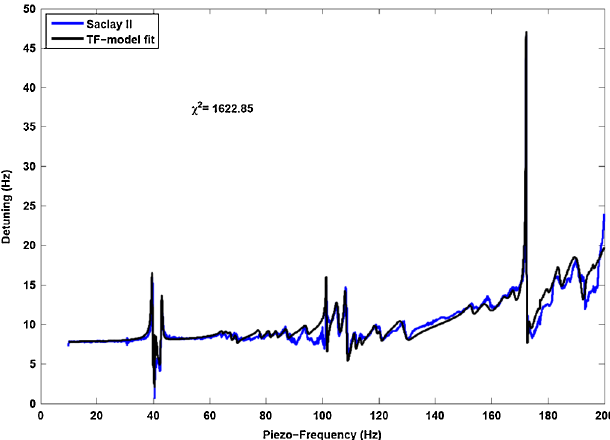
FIG. 13. (Color) Fit of the model given by Eq. (10) to the type II tuner transfer function in the subrange of 10–200 Hz.